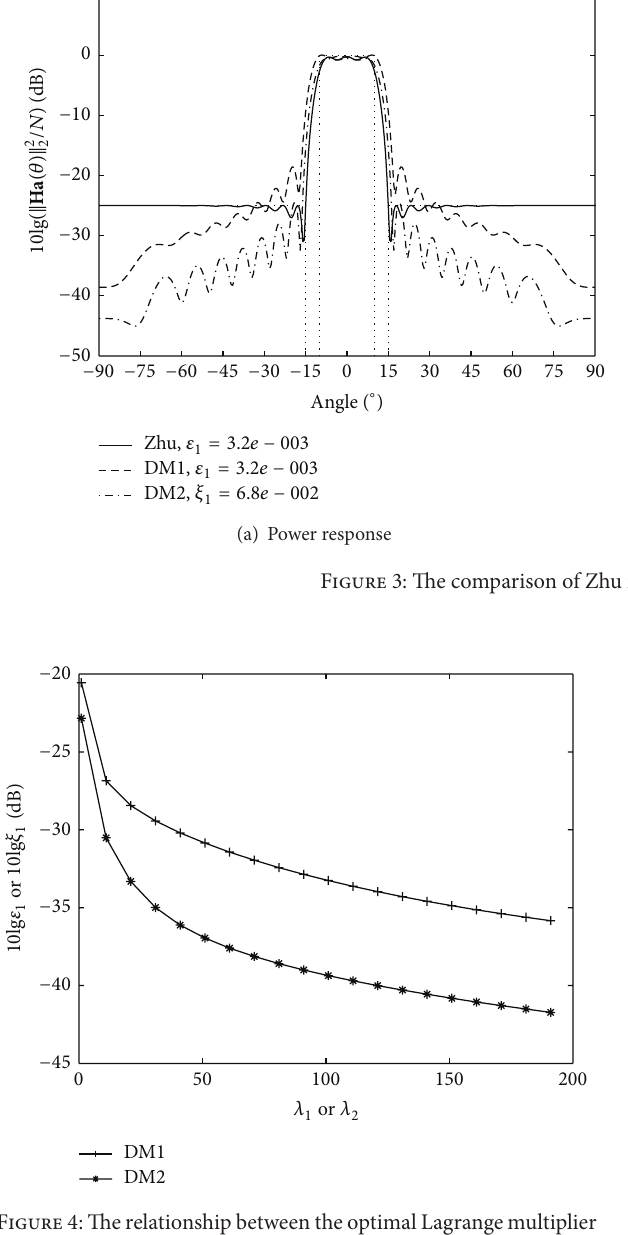
𝜀 1 (the passband fidelity